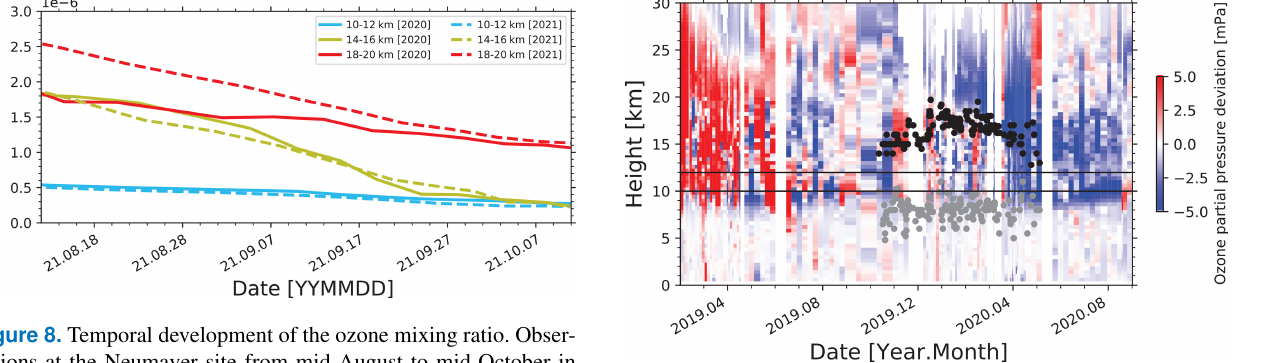
Figure 9. Deviation of each individual ozone profile from the re- spective long-term (2010–2019) monthly mean ozone profile. Mea- surements at the Ny-Ålesund (78.9 ◦ N) station are used. The solid horizontal lines mark the PSC-free height range (10–12km). The base (gray dots) and top heights (black dots) of the Siberian smoke layer measured with Polly aboard Polarstern on a daily basis indi- cate the smoke-polluted height